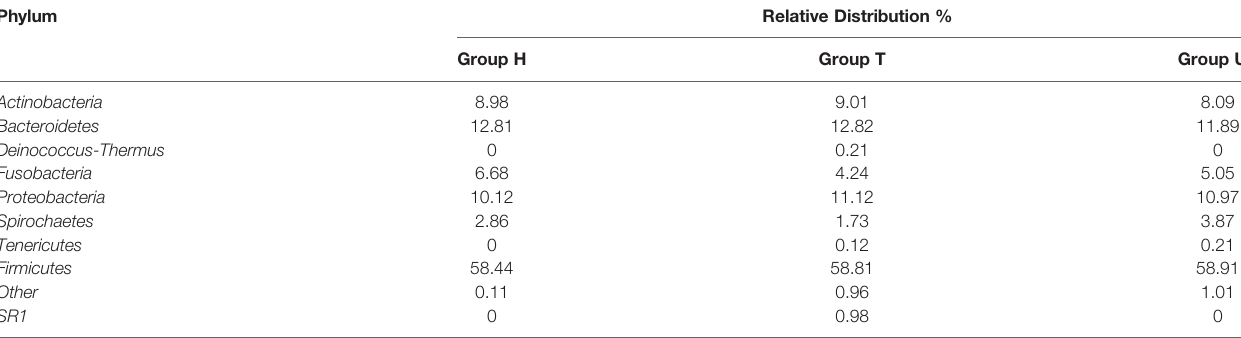
TABLE 4 | Relative abundance of microbial diversity in saliva samples at the phylum level for different subgroups.